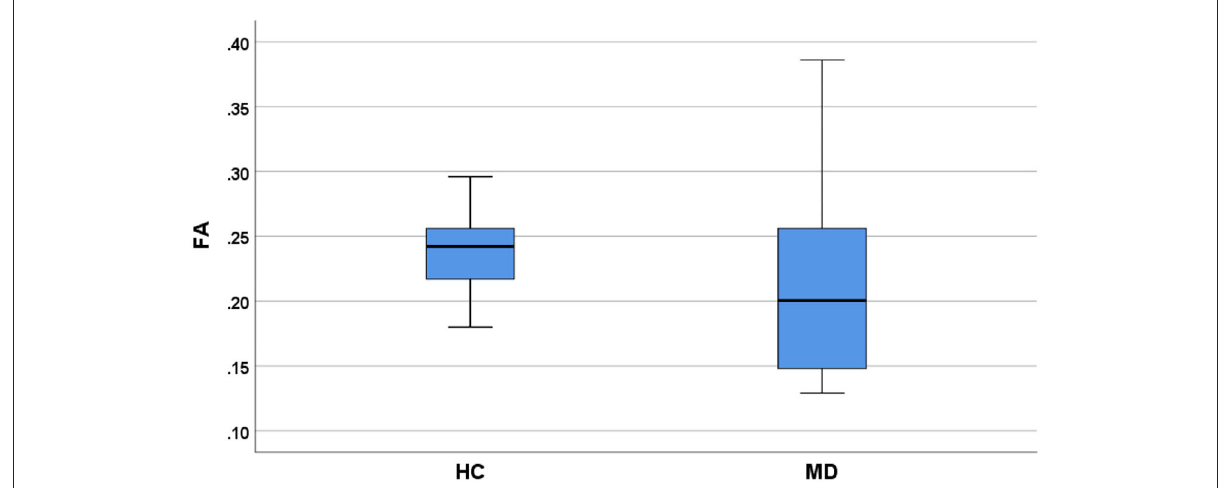
FIGURE3 Comparison of FA values (VCN) between MD patients and healthy controls (HC).